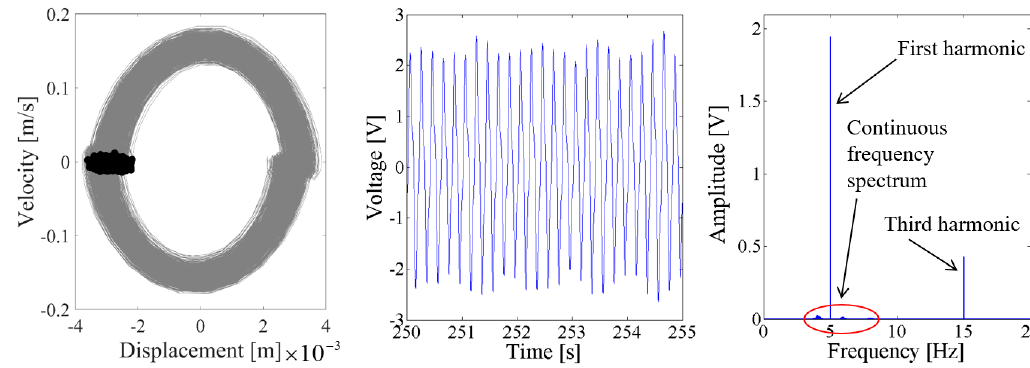
Figure 19. Dynamic responses of the coupled harvester-2 for the excitation level of 0.9 g. Sensors 2018 , 18 , x FOR PEER REVIEW